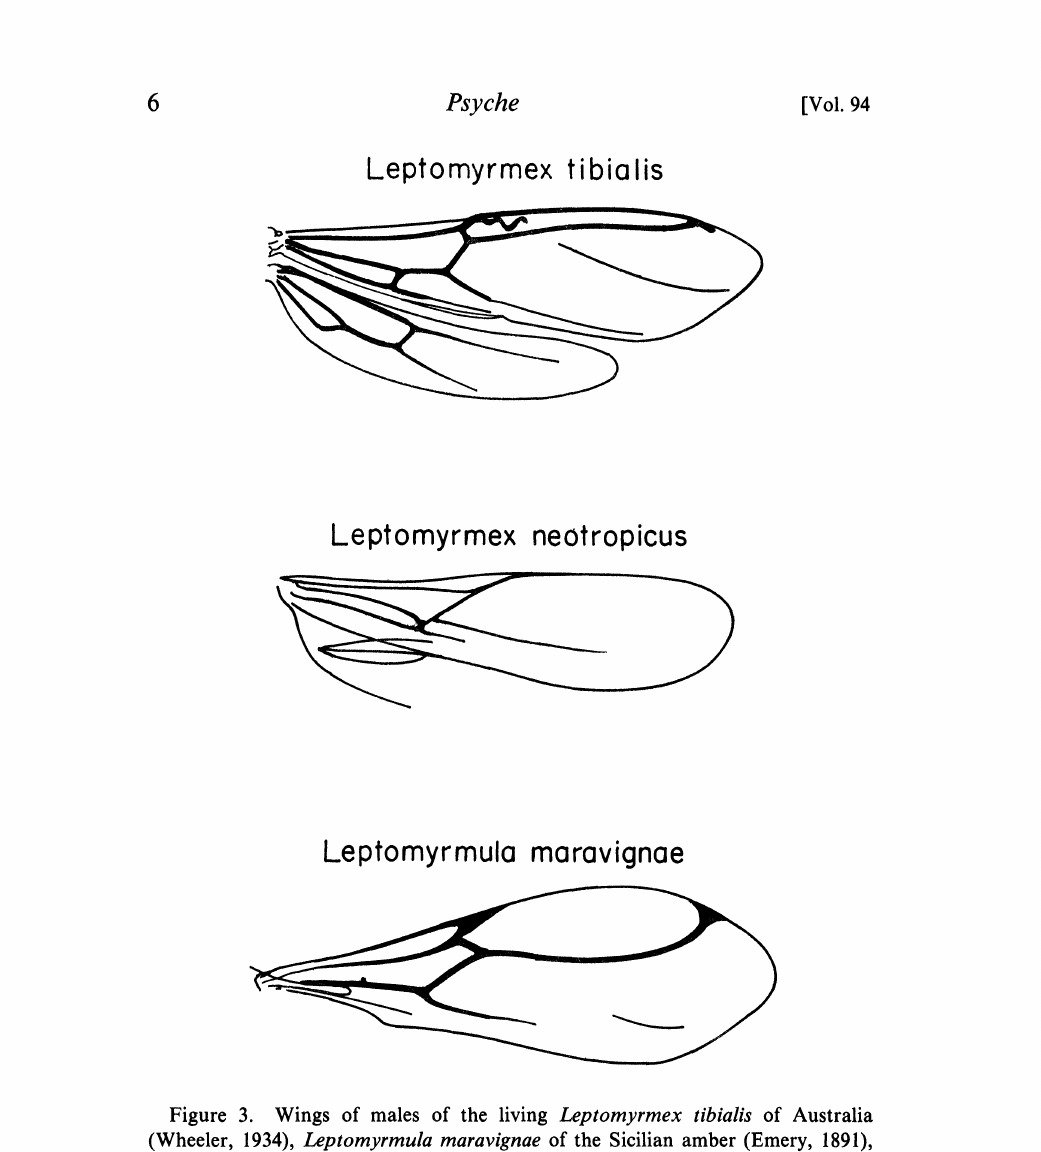
Figure 3. Wings of males of the living Leptomyrmex tibialis of Australia (Wheeler, 1934), Leptomyrmula maravignae of the Sicilian amber (Emery, 1891), and the putative Leptomyrmex